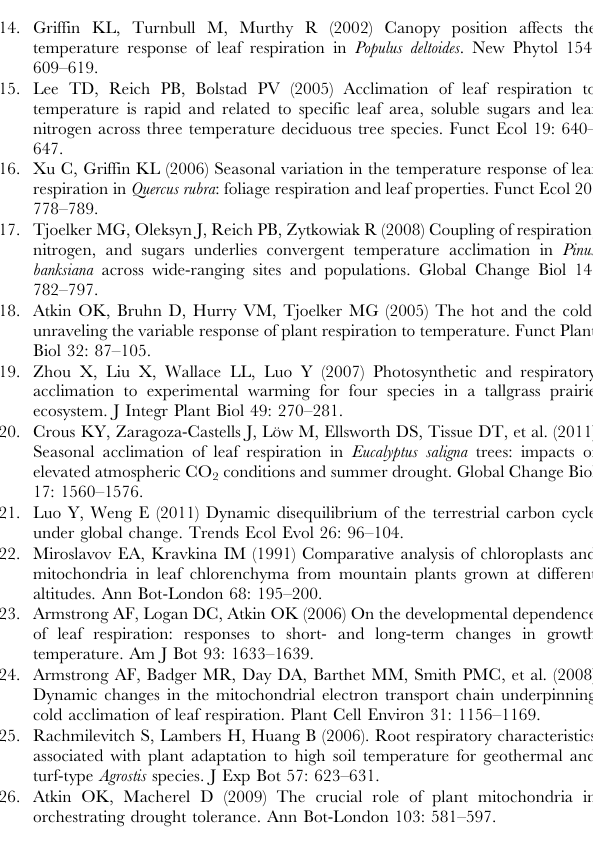
Table S1 Results ( P -values) of two-way ANOVA on the effects of warming, year, and both interactions on the responses of A n (the net CO 2 assimilation rate), R d